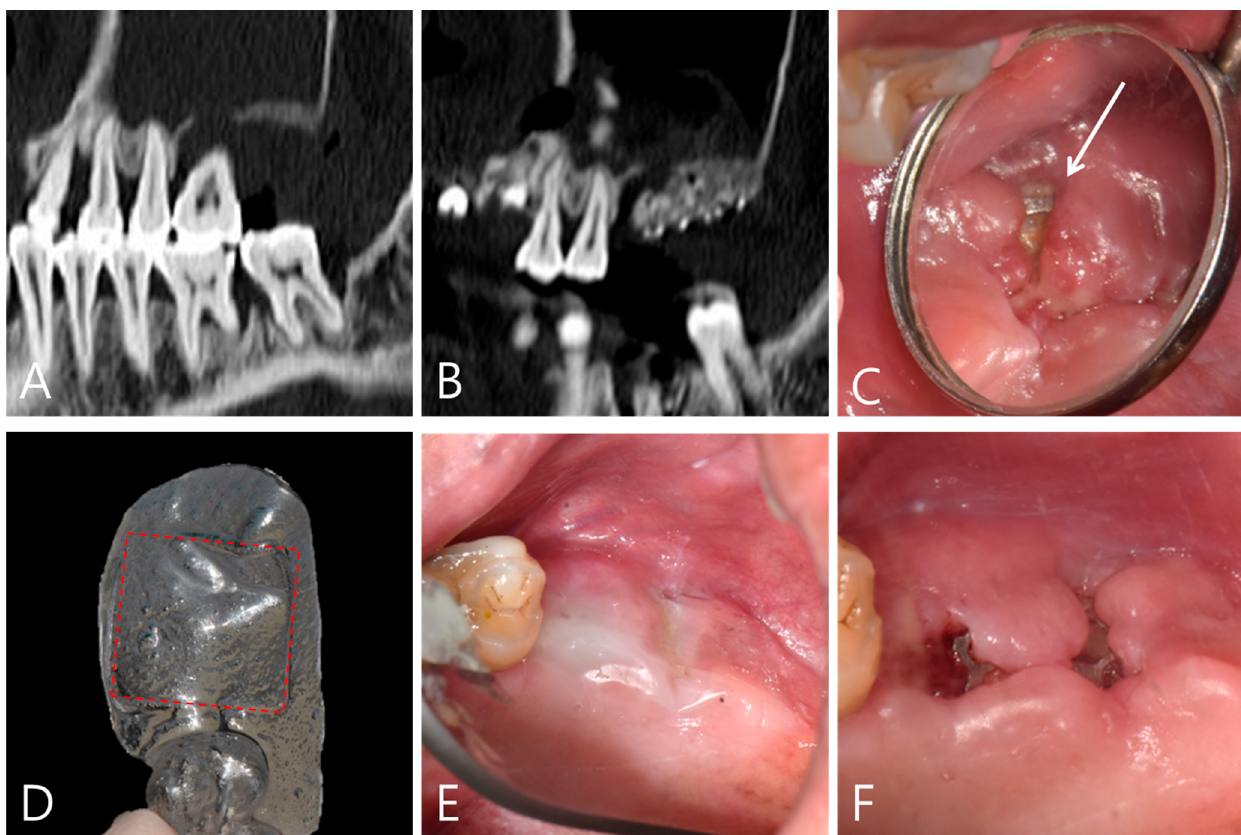
Figure 4. Wound dehiscence after an autogenous tooth bone graft with a titanium mesh of case #2. ( A ) Pre-operative radiograph on the left maxillary molars showed a large defect with an oroantral fistula. ( B ) A bone graft was performed with autogenous ramus bone covering a titanium mesh on the left maxilla. ( C ) At 3 weeks after surgery, wound dehiscence occurred with an exposed titanium mesh (arrow). ( D ) A partial omnivac splint was fabricated from the impression with the dressing application (red dot squire). ( E ) The dressing material showed intimate adhesion on the dehiscence. ( F ) Secondary healing was observed under the mesh at two weeks after conservative treatment.